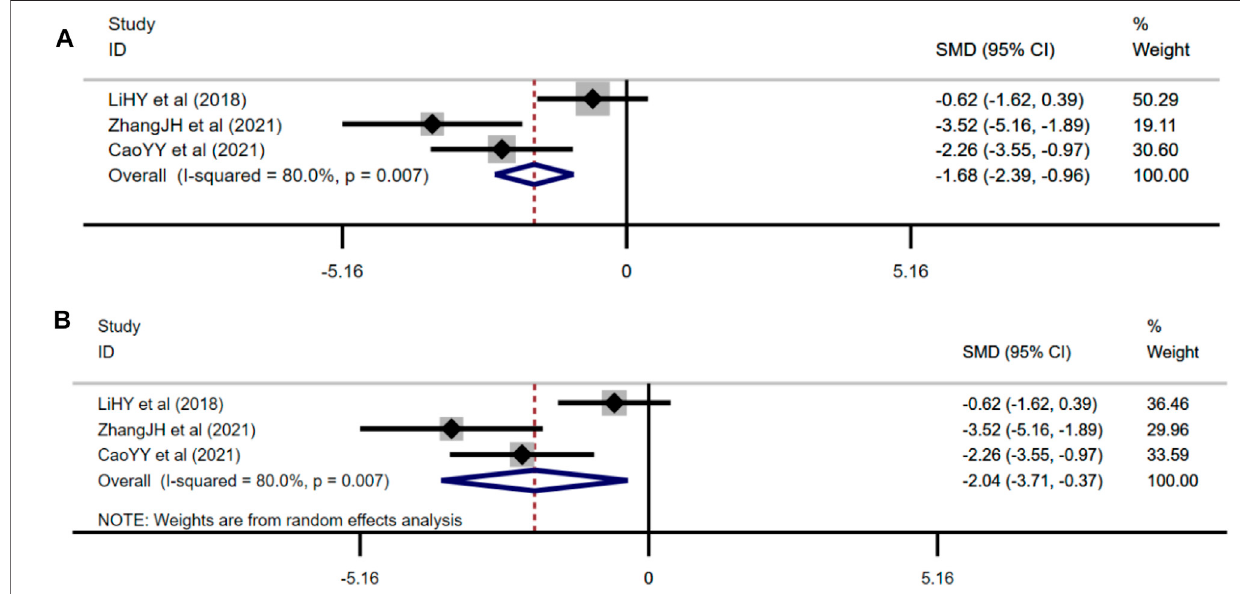
FIGURE 5 | Forest plot: effect of berberine on (A) serum insulin and (B) 2hBG of OGTT.